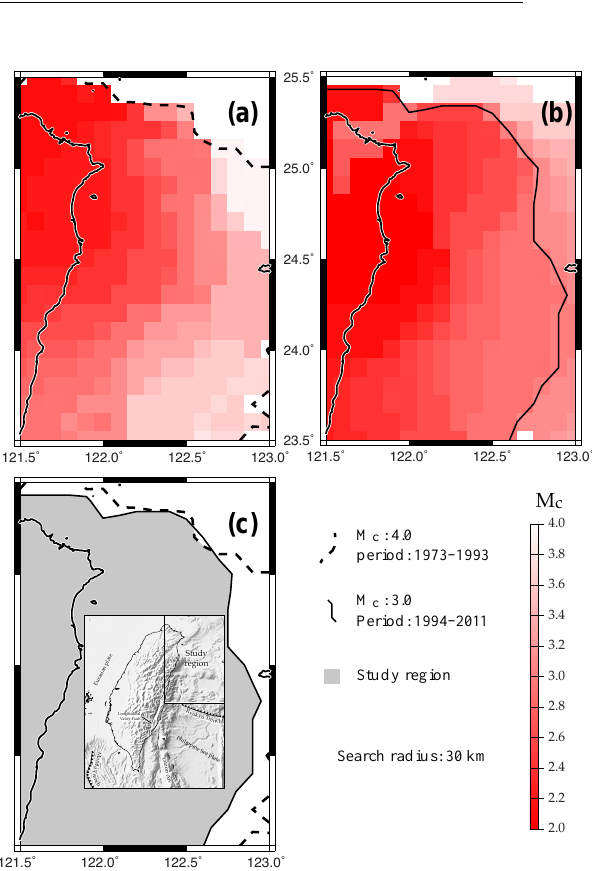
Figure 1. The magnitude of completeness ( M c ) for (a) the TTSN and (b) the CWBSN catalogues. (c) The study area is shown in grey, with the intersection of regions with M c ≤ 4.0 for the TTSN shown with dashed lines and with M c ≤ 3.0 for the CWBSN shown with solid lines. The M c for each grid is determined according to the events that occurred within 30km of the centre of each